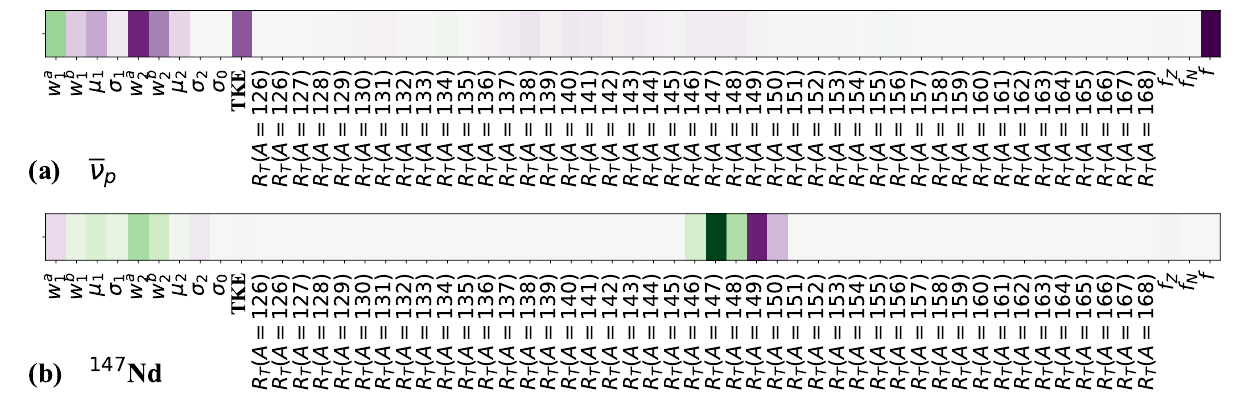
Figure 1. Sensitivities for (a) ν p and (b) the cumulative fission product yield for 147 Nd to the fitted parameters in BeoH . Dark green (purple) indicates regions of high (anti-)correlation; white regions indicate no correlation.